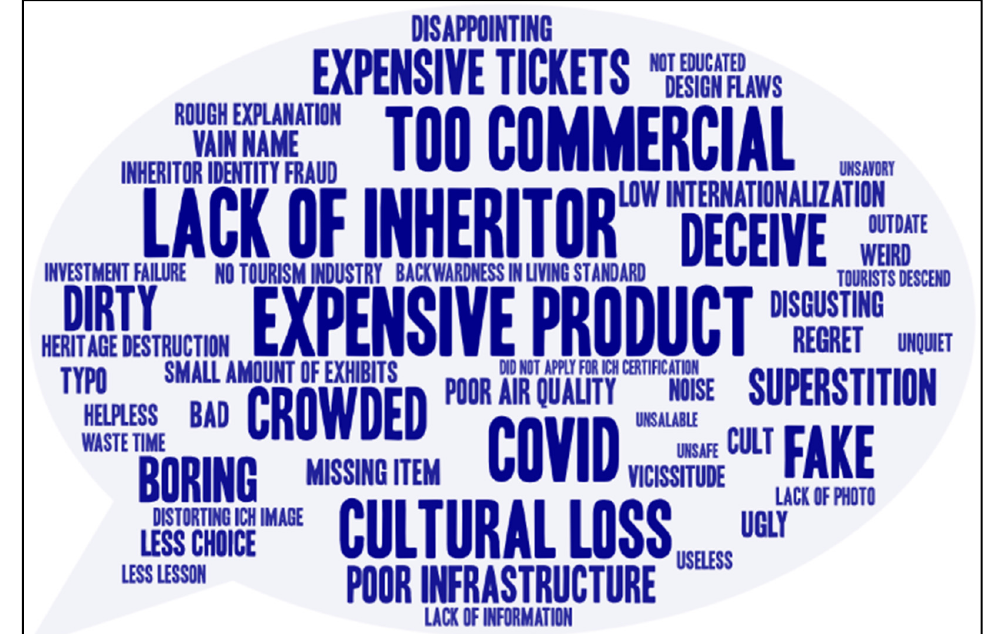
Figure 3. Keyword analysis of negative sentiment reviews.